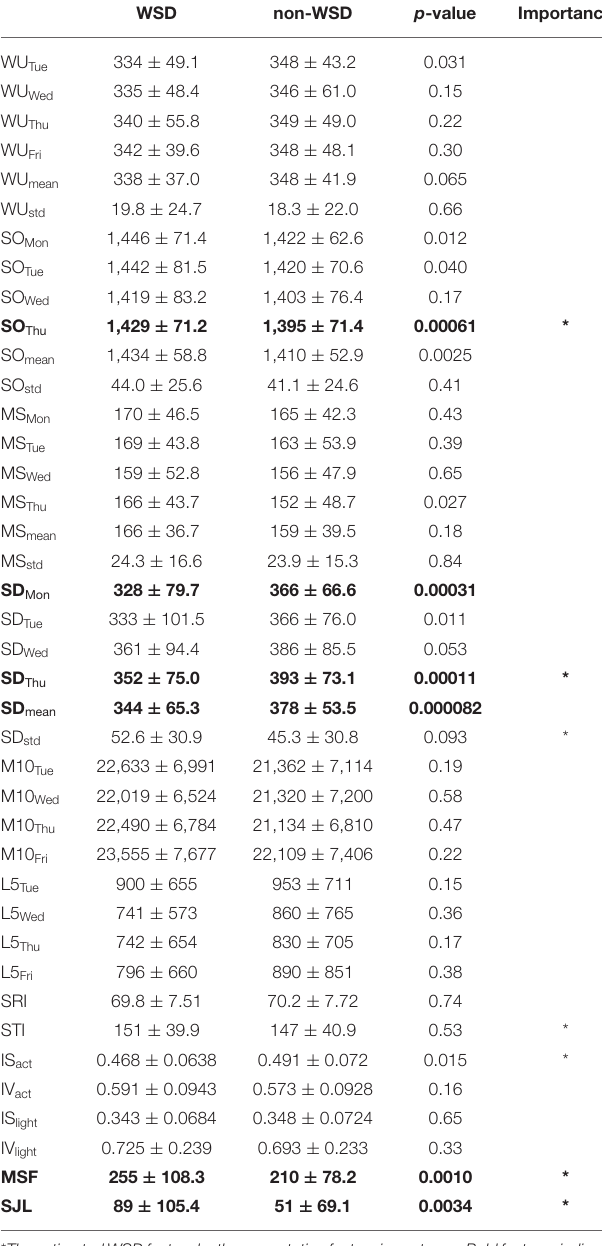
TABLE 5 | Comparison of measurements between the two groups (significance level with the Bonferroni correction: p < 0.00125). WSD non-WSD p